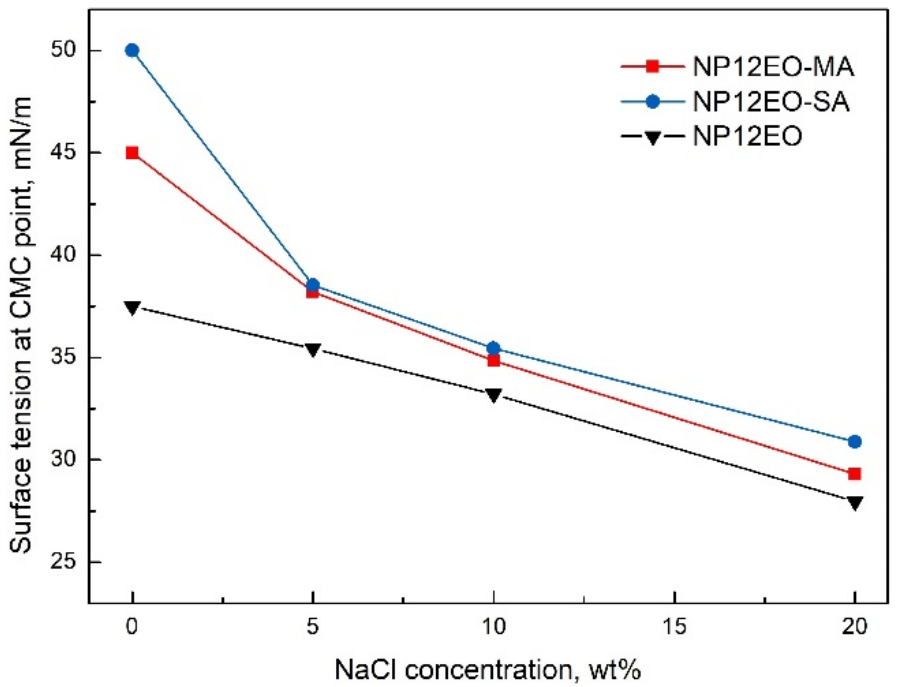
Figure 6. Surface tension at CMC point ( γ CMC ) of NP12EO-SA, NP12EO-MA, and NP12EO.